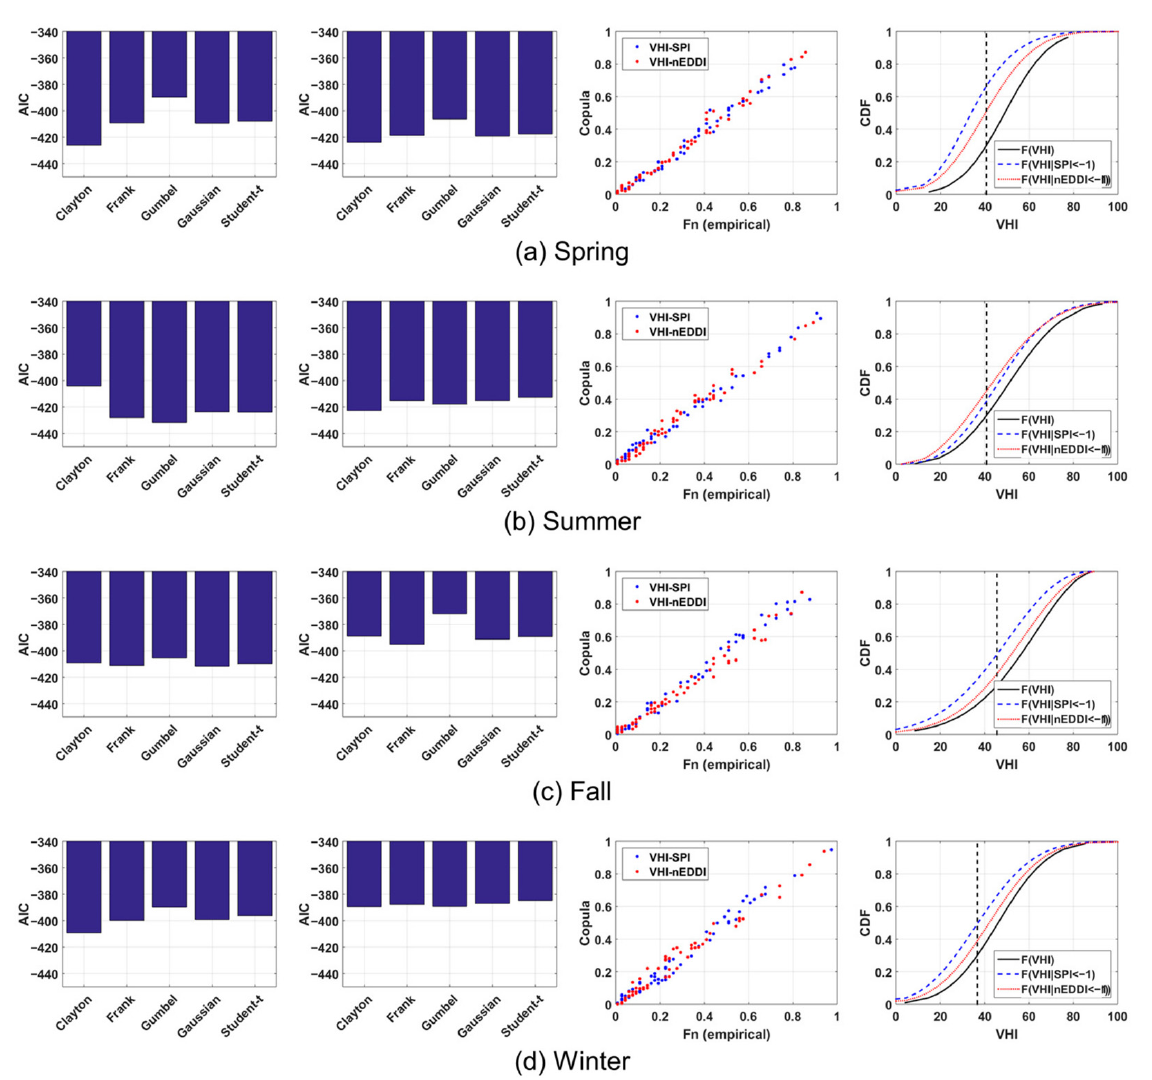
Figure 8. AIC values of five copulas for VHI and SPI (Far left), AIC values of five copulas for VHI and nEDDI (Center to left), Q-Q plot using best-fitted copula (Center to right), and conditional CDF of VHI under two meteorological drought scenarios: SPI ≤ − 1 and nEDDI ≤ − 1 (Far